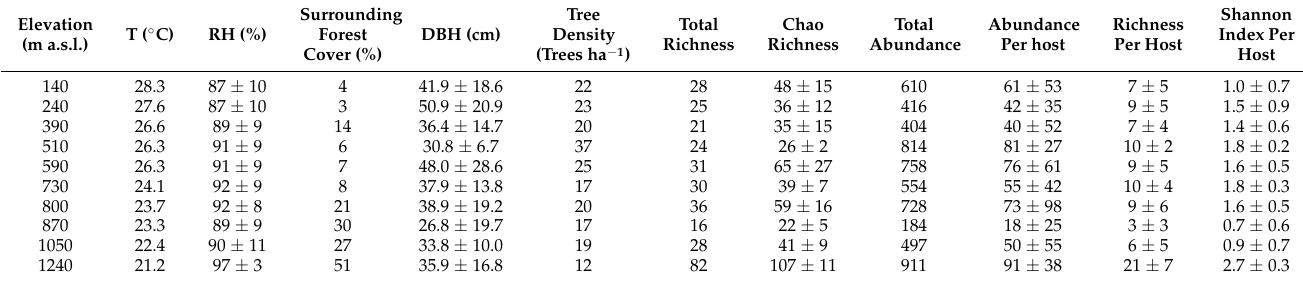
average ± standard deviation (x ± SD).